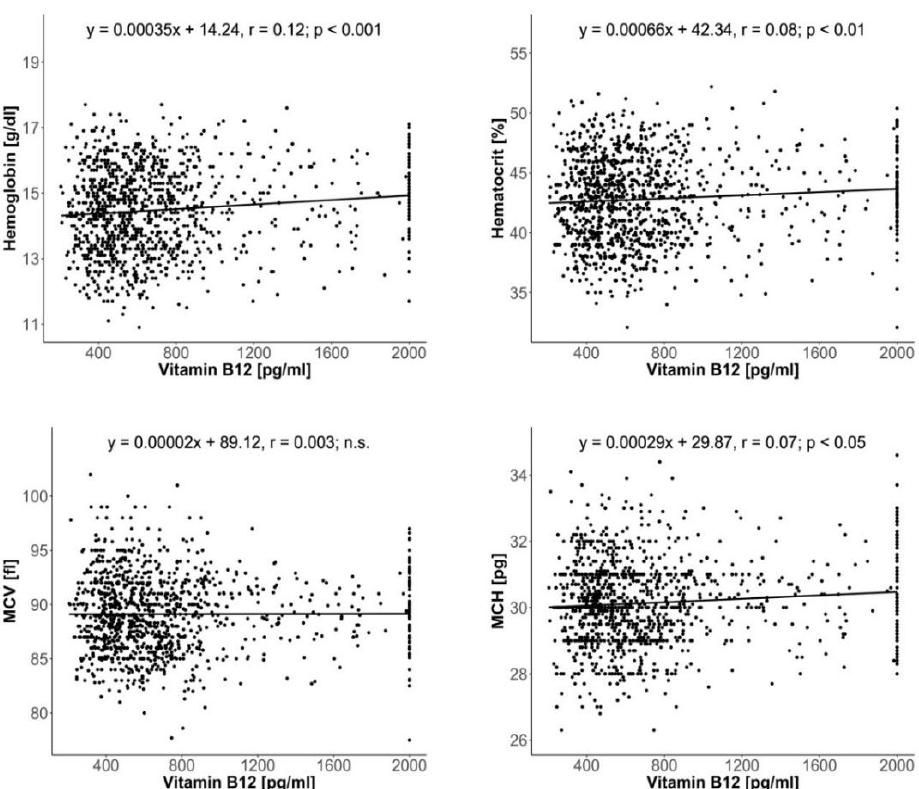
Figure 1. The correlations between total serum vitamin B 12 concentration and hematological indices: hemoglobin concentration, hematocrit, mean corpuscle volume (MCV) and mean corpuscle hemoglobin (MCH).